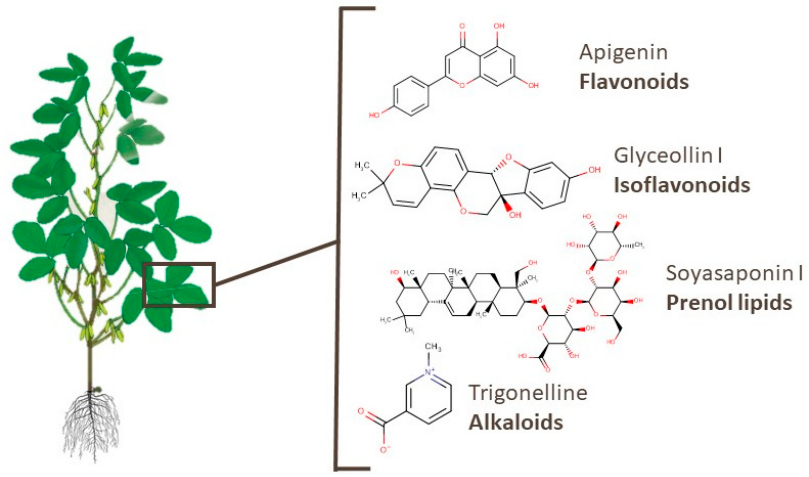
Figure 6. Chemical structures of apigenin, glyceollin I, soyasaponin I, and trigonelline, which are examples of bioactive compounds identified in soy leaves.